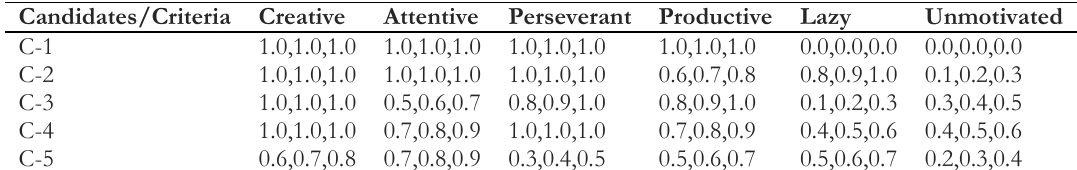
Table 1. Fuzzy membership degrees of the characteristics of five candidates in the first time span in the decision